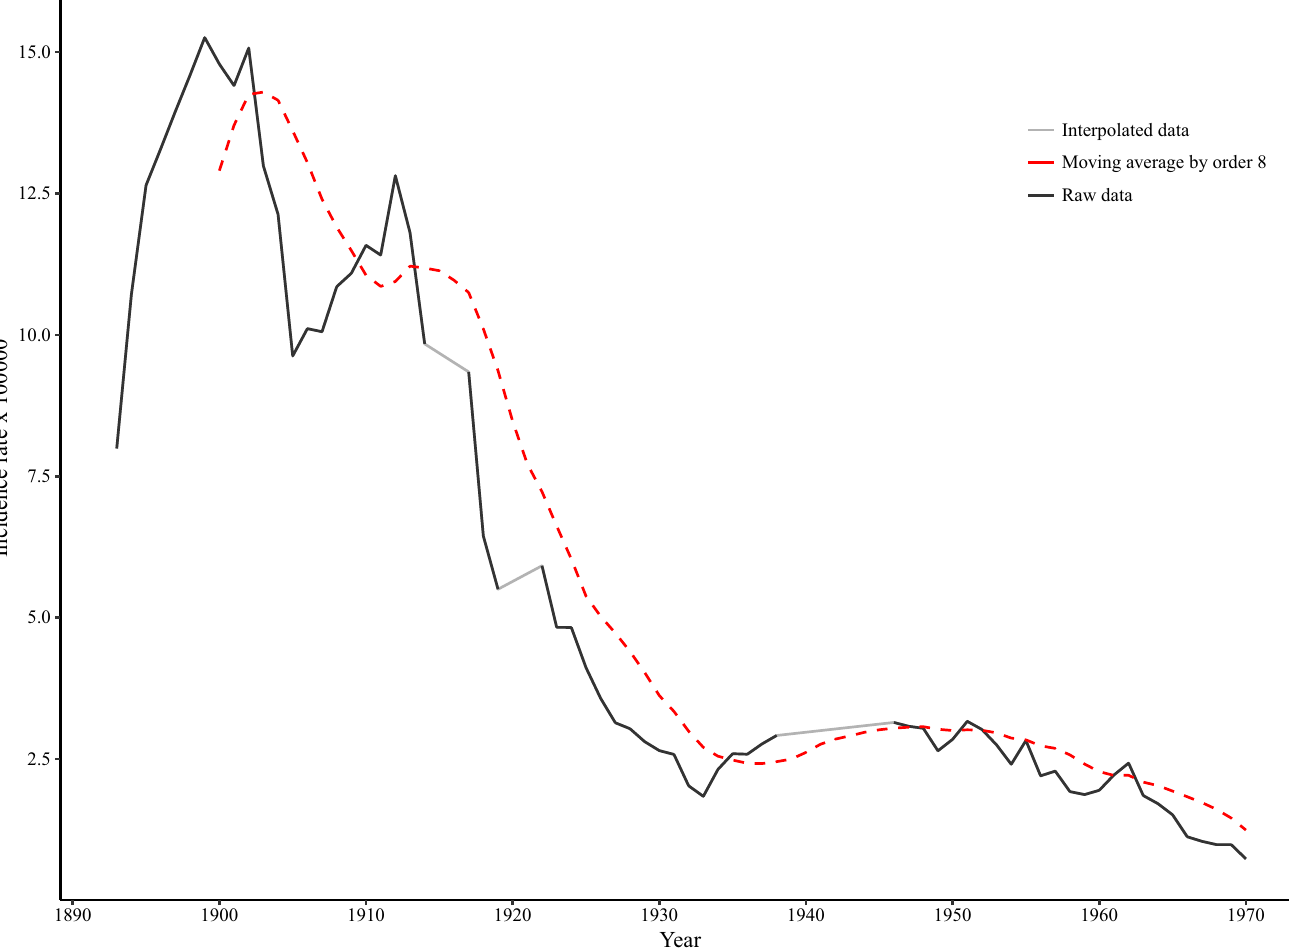
Fig 2. Persons guilty of Cruelty to children from 1893 to 1970. The graph plots the raw data (black) , interpolated data (grey) ,and an eight-year moving average (red) of the age-standardised incidence (per 1000,000) of persons found guilty of the criminal offence, Cruelty to children , by calendar year.